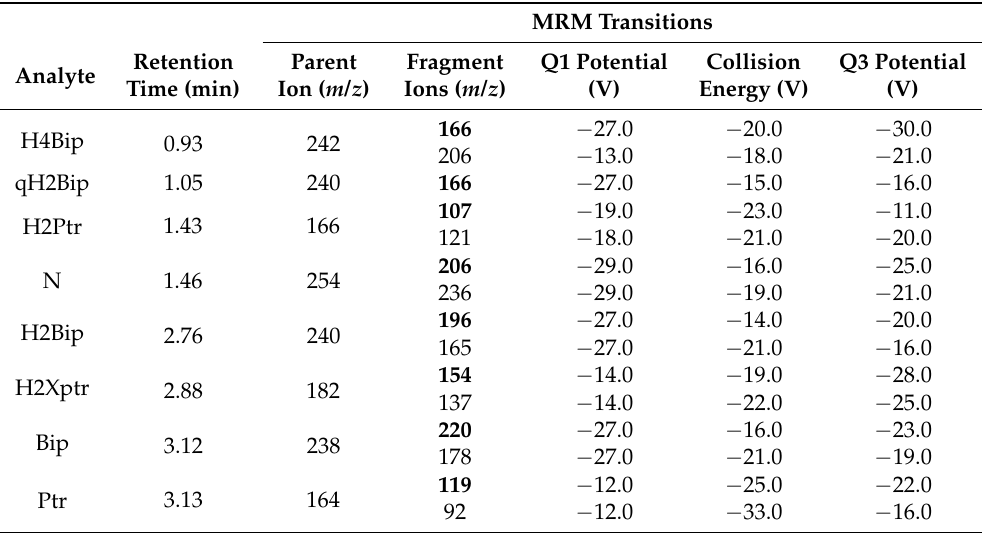
Table 1. MS/MS transitions of targeted pterins (most intense fragment in bold). H4Bip (Tetra-hydro- biopterin), qH2Bip (Quinonoid dihydro–biopterin), H2Ptr (Dihydro-pterin), N (Neopterin),